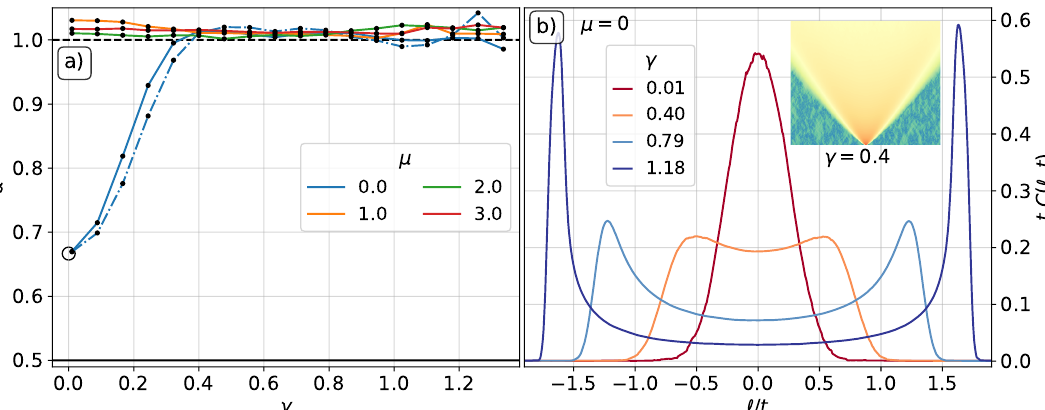
Figure 8: (a) Finite-time dynamical exponents α (full blue line for t ∈ [ 300,1000 ] , blue dashed-dotted line for t ∈ [ 100,300 ] ) as functions of anisotropy for different values of chemical potentials µ . At all µ > 0, we find ballistic transport ( α = 1). At µ = 0 and γ → 0, the dynamical exponent crosses over to superdiffusion with α = 2 / 3 (black circle). (b) Rescaled ballistic stationary profiles of the dynamical structure factor t C ( (cid:96) , t ) at µ = 0.